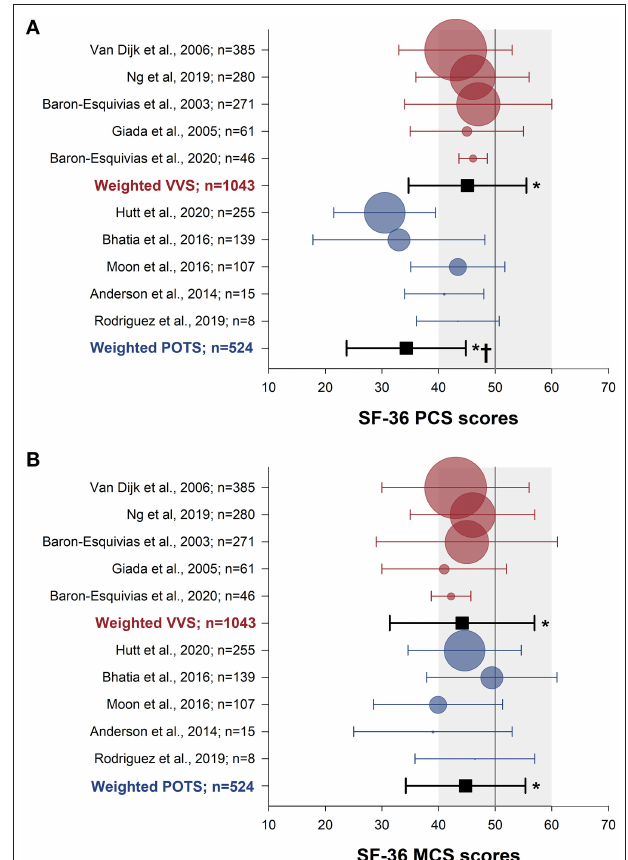
FIGURE 2 | Meta-analysis of SF-36 summary scores in patients with VVS and POTS compared to normative data. Physical (A) and mental (B) component summary scores are shown for patients with VVS ( 27–30, 56) (red) and POTS (41, 43–46) (blue). Data for each study are presented as the mean (circle) and standard deviation (whiskers) with the size of the circle proportional to the study sample size. Weighted means and standard deviations for combined data for patients with VVS and POTS are indicated with black squares. Vertical lines and gray shading denote the mean and standard deviation based on US normative data ( n = 2,474) (58). *Significantly different to US normative data at the 0.001 level of significance. † Significantly different to the VVS group, at the 0.001 level of